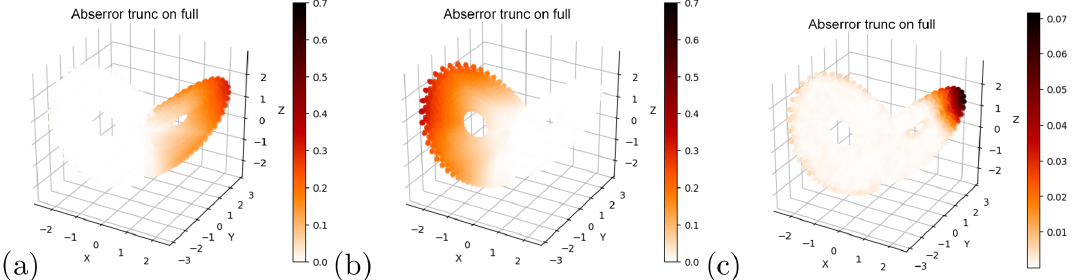
Figure C1. Same as Fig. 2d–f but for networks forecasting the tendency instead of the following state. Note the different color scale in (c) .